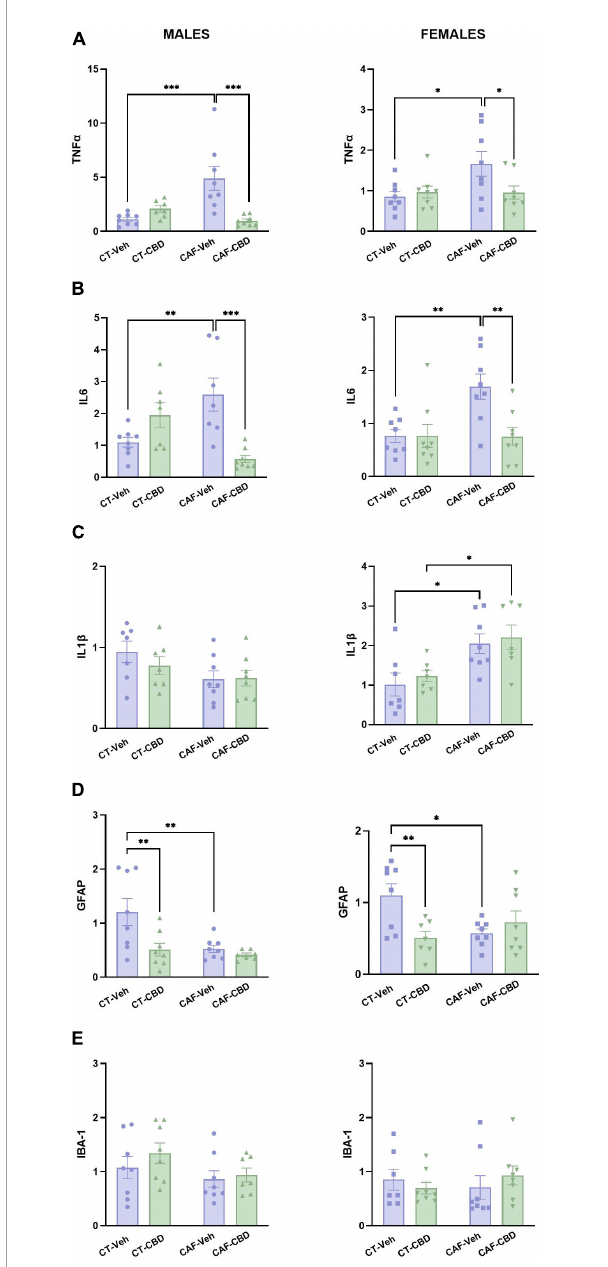
FIGURE7 Relative gene expression of tumor necrosis factor-alpha (TNF α ), interleukin 6 (IL6), interleukin 1 β (IL1 β ), glial fibrillary acidic protein (GFAP), and ionized calcium-binding adapter molecule 1 (IBA1) in the hypothalamus of the offspring. Maternal obesity increased the expression of TNF α (A) and IL6 (B) in both males and females, with a positive effect of cannabidiol (CBD) treatment. Maternal obesity increased the expression of IL1 β only in females, with no effect of CBD (C) . Both maternal obesity and CBD treatment decreased GFAP expression in males and females when compared to control diet (CT) (D) . No difference was found in IBA1 expression (E) . Data are presented as mean ± SEM. n = 6–8/group. ∗ p < 0.05 ∗∗ p < 0.01 ∗∗∗ p <